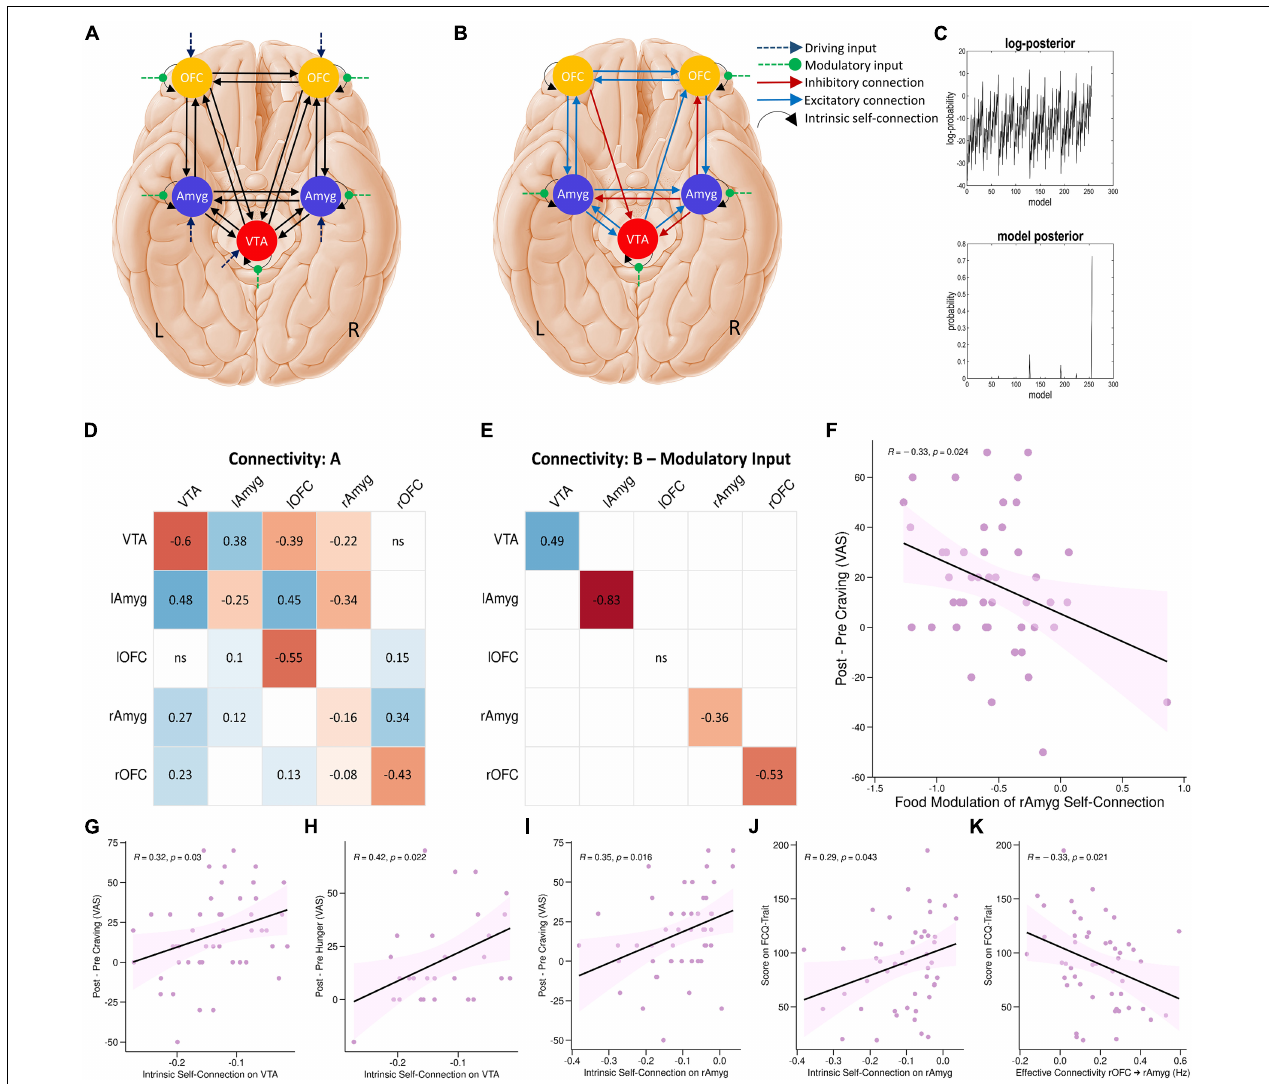
FIGURE 4 | DCM results. (A) The parent DCM model was defined and inverted at the single-subject level, which included all intrinsic self-connections and extrinsic between-region connections in each hemisphere, food and neutral stimuli as driving input, and food modulation of all intrinsic connections. (B) The winning DCM model after post hoc Bayesian model selection, green arrows indicate modulation by the food stimuli. (C) The upper panel shows the range of log-posterior probabilities of all possible models examined. The bottom panel shows the posterior probability for all reduced models. It shows that the winning model had the posterior probability of 0.73, which indicates that the model had more evidence than any other model. The next most probable model was M128 with a posterior probability of 0.14 (the log-probability of 11.66). (D,E) The corresponding connectivity matrices for winning DCM model. Matrices A and B correspond to connection strengths and input modulations of connections, respectively. (F) Correlations between neural and behavioral findings. Individual parameter estimates of food modulation on the inhibitory intrinsic connection of the right amygdala correlated with craving changes ( (cid:49) craving effect post-fMRI - pre-fMRI) ( R = –0.33; P = 0.024; Pearson’s correlation). Individual intrinsic self-connection of the VTA node predicted participants’ scores on the self-reported craving ( R = 0.32; P = 0.03; Pearson’s correlation) (G) and hunger ( R = 0.42; P = 0.022; Pearson’s correlation) (H) . Also, intrinsic self-connection of the right amygdala node correlated with participants’ scores on the self-reported craving ( R = 0.35; P = 0.016; Pearson’s correlation) (I) and the FCQ-Trait ( R = 0.29; P = 0.043; Pearson’s correlation) (J) . Individual extrinsic connections from the right OFC to right amygdala correlated with scores on the FCQ-Trait ( R = –0.33; P = 0.021; Pearson’s correlation) (K) . lAmyg,